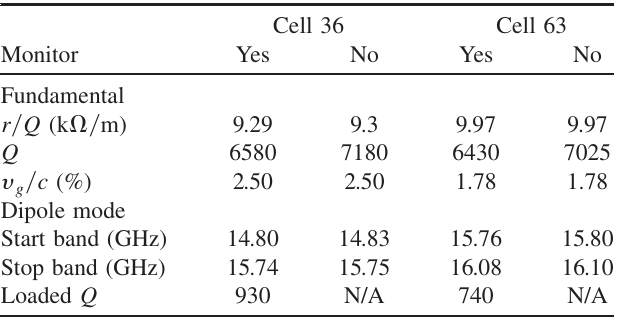
TABLE II. Parameters of monitor cells with and without wake coupler.